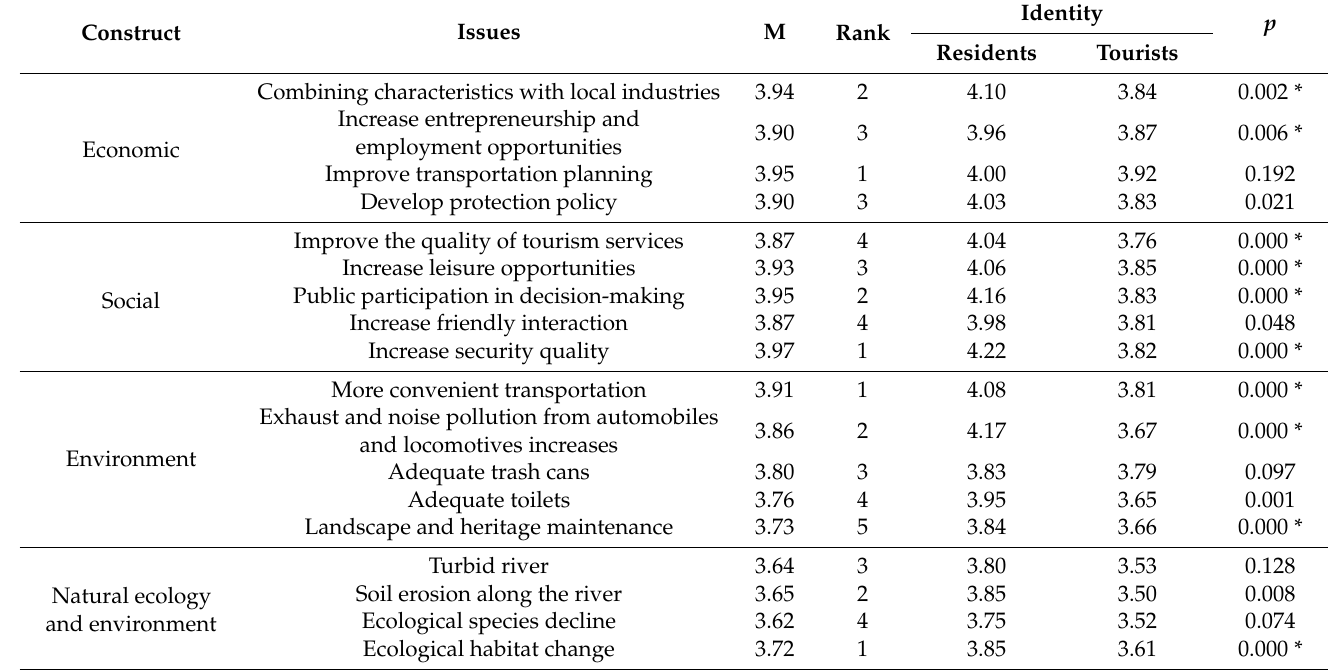
Table 5. Analysis of the public’s cognition of the development status of urban economy, society, environment, and natural ecological